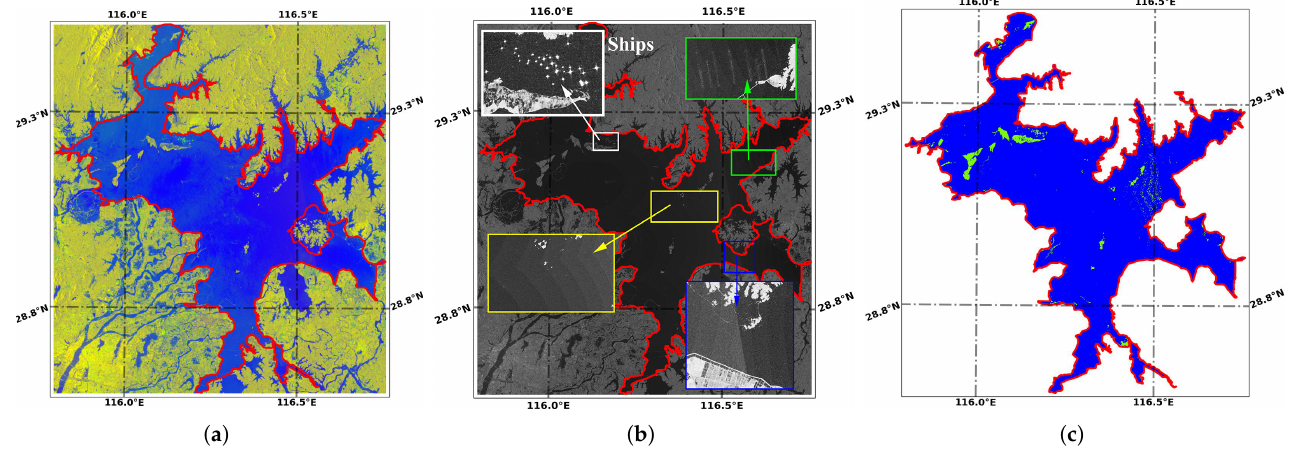
Figure 17. The influences of subswath and scalloping effects on water extraction, taking the data acquired on 14 July 2020, as examples. The blue box in ( b ) shows the enhanced subswath edge, while the green and yellow box show the scalloping effect. The corresponding area in ( c ) shows water misclassified as non-water, with blue for water and green for non-water. ( a ) Sentinel-1 SAR data in VH/VV/(VH + VV); ( b ) Sentinel-1 SAR data in VH; ( c ) classification